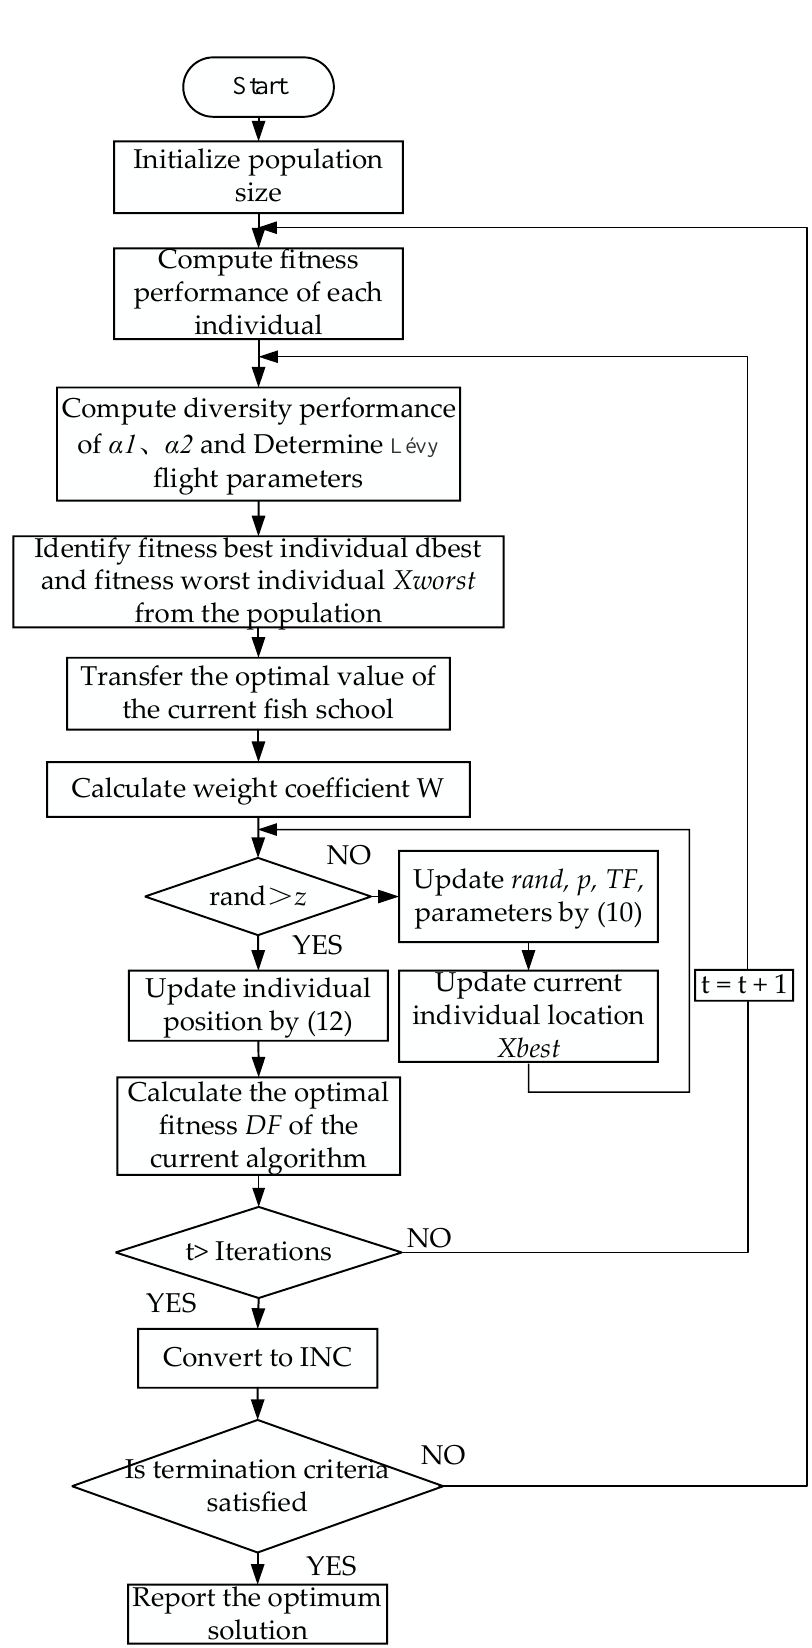
Figure 7. Flow chart of the ITSO-INC algorithm.